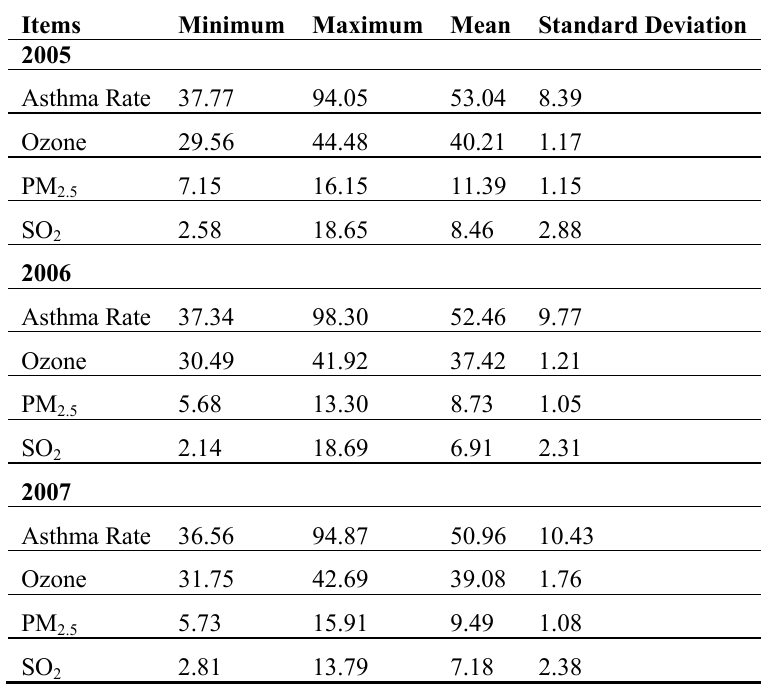
Table 1. Descriptive statistics of annual average pollution concentrations in New York State. Items Minimum Maximum